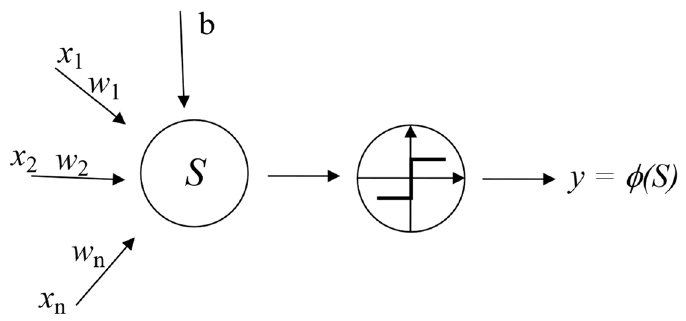
Figure 3. Signal processing in an artificial neuron, where: x i —input signal, b—bias, y —neuron signal, w i —weights, ϕ —activation function, S output signal, w i —weights, φ — activation function, S —sum.